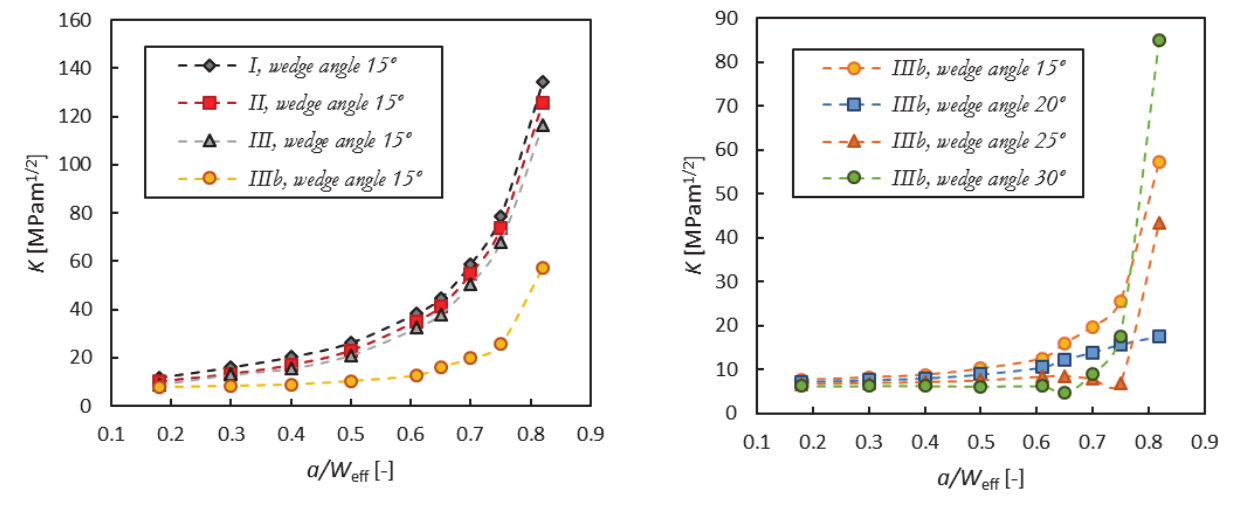
Figure 4 : Stress intensity factor ( K I ) as a function of the relative crack length, α /W eff , for the combined bending/splitting variants defined in Fig. 1, loaded by P sp = 1000 N, on the left side for wedge angle =15° and on the right side for variant IIIb for various wedge